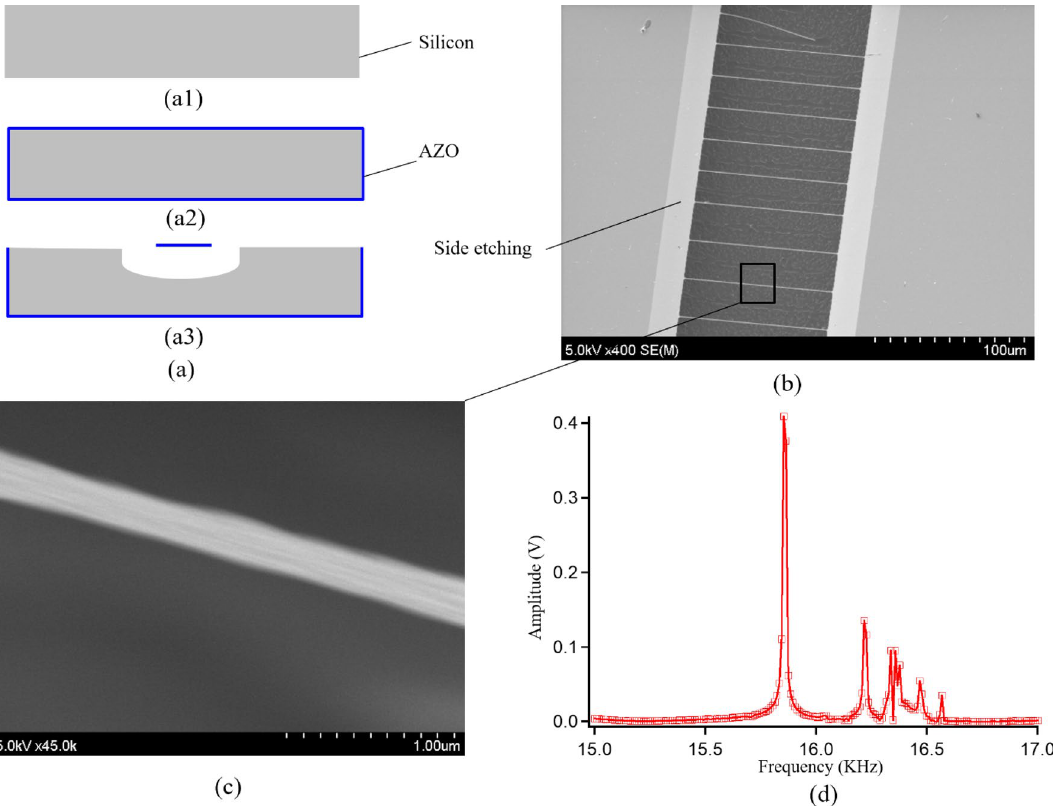
Figure 7. Fixed–fixed nanobeam structure. ( a ) Fabrication process. ( a1 ) Silicon wafer. ( a2 ) ALD process. ( a3 ) Nanobeam structure. ( b ) Fabricated nanobeam structure. ( c ) Close-up image of nanobeam structure. ( d ) Frequency